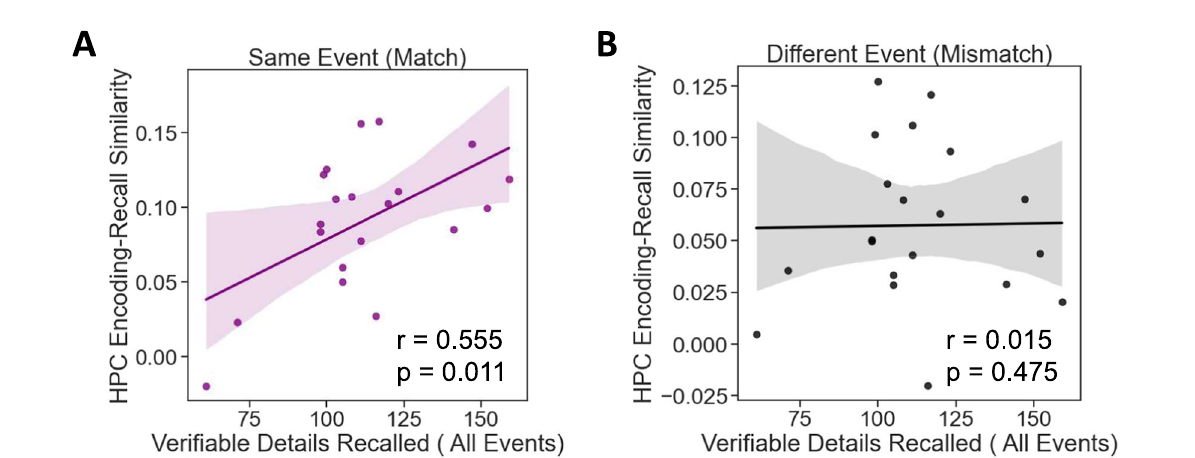
Fig. 7 | Correlation between HPC reinstatement at recall and the overall num- ber of veri fi able details retrieved across all events. Correlations are shown for A matched events and B mismatched events. ( N =20 participants, shaded